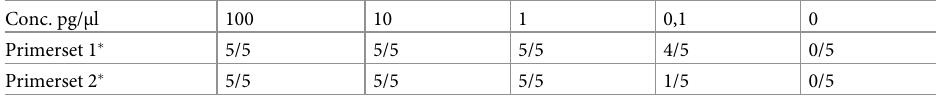
� shown are positive results out of five independent